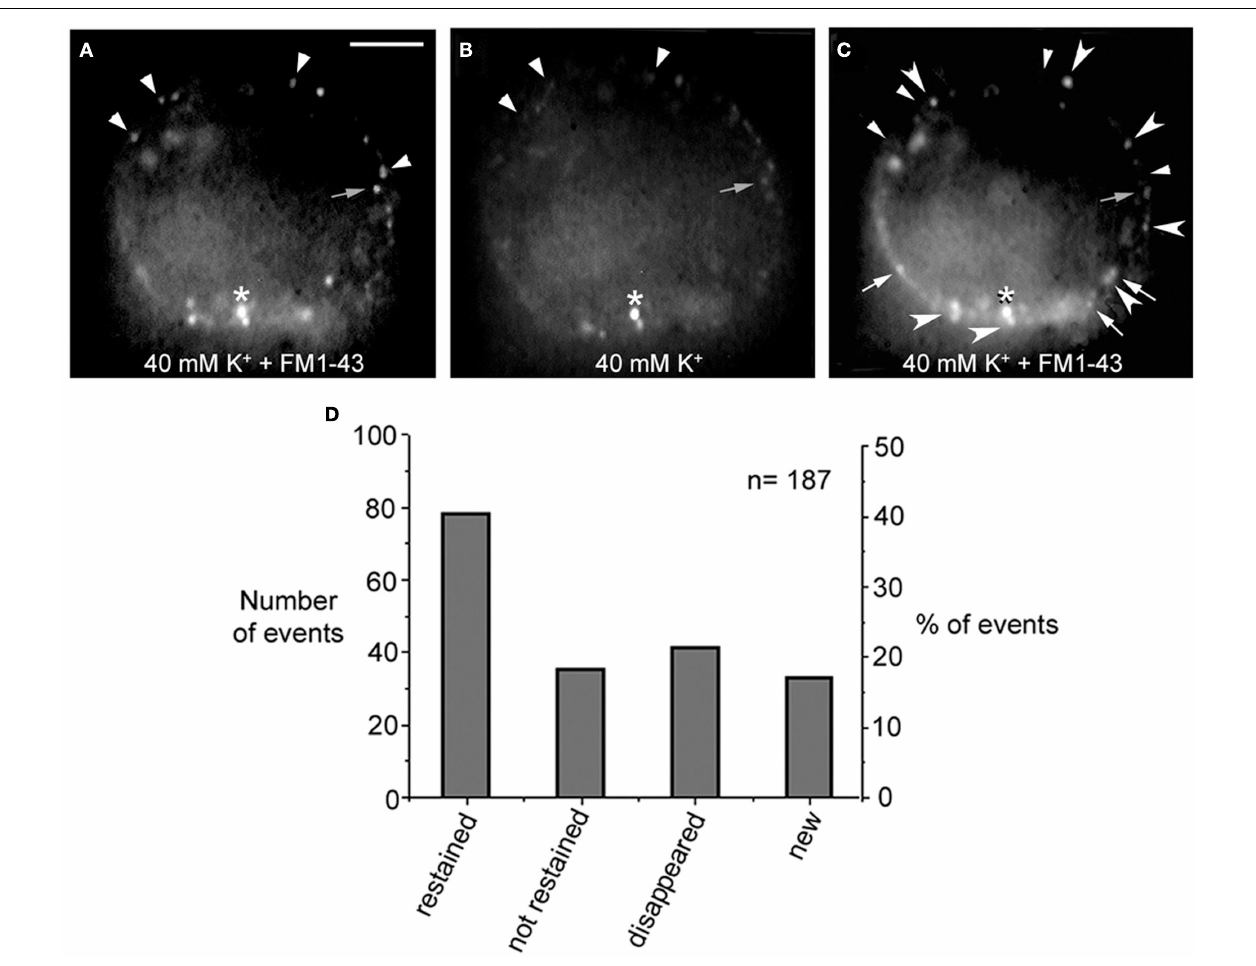
photobleached to allow the testing of whether spots that were originally stained became restained. (C) After a second depolarization in the presence of fresh external FM1-43, some of the spots were restained (large arrowheads), some were not restained but could still be detected in their previous position (gray small arrows), others disappeared completely (small arrowheads), and others were newly formed (white arrows). Scale bar = 20 μ m. (D) Graph of the distribution of the total number and percentage of fluorescent spots in each category described